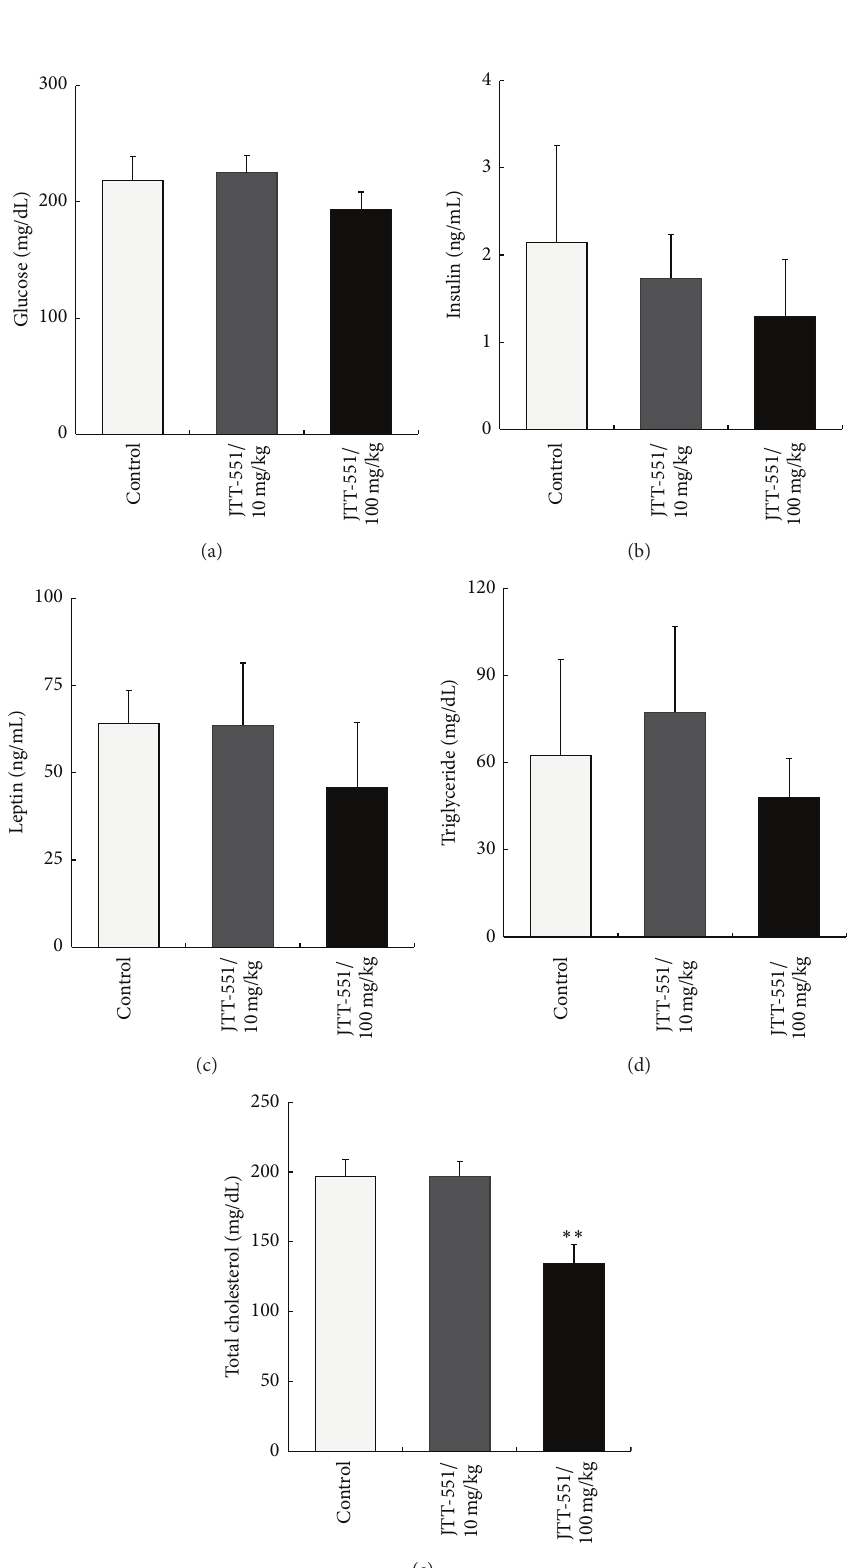
Figure 4: Effects of JTT-551 on blood glucose (a), insulin (b), leptin (c), triglyceride (d), and total cholesterol levels (e) in fed DIO mice. DIO mice were given 10 or 100 mg/kg food containing JTT-551 for six weeks. Data represent mean ± SD ( 𝑛 = 6 ). ∗∗ 𝑃 < 0.01 : significantly different from the control by Dunnett’s test